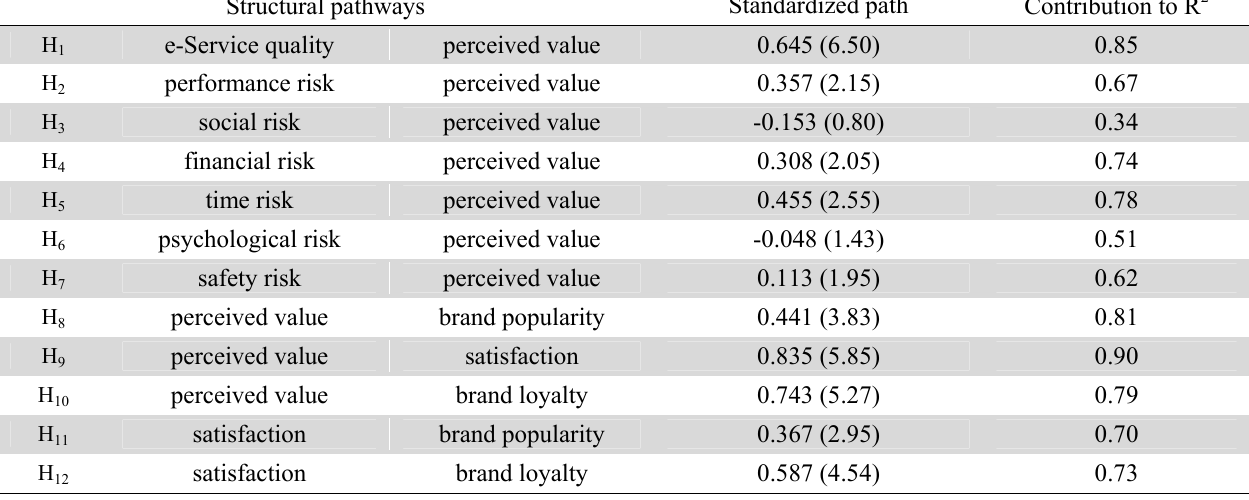
Result of PLS software